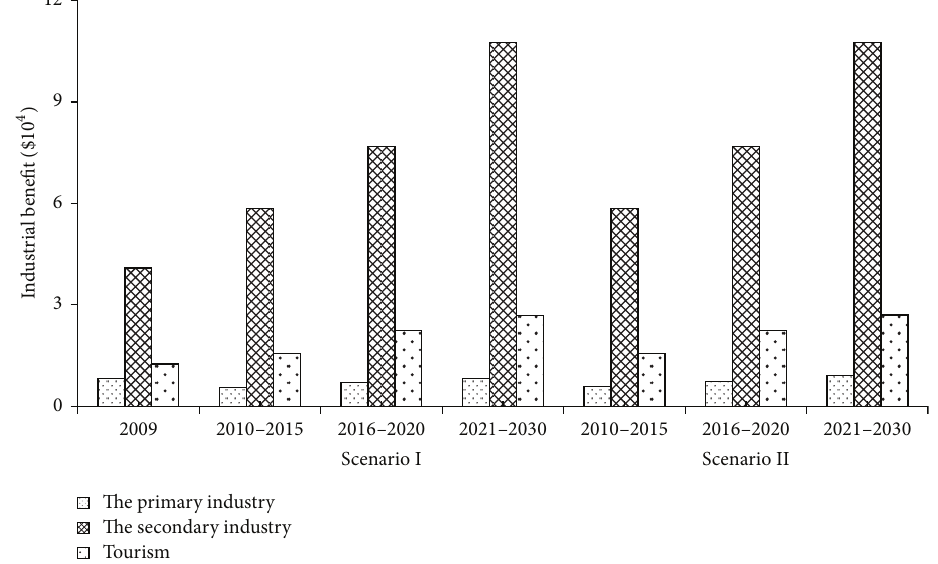
Figure 4: Three-industry structure of the representative optimization scheme.